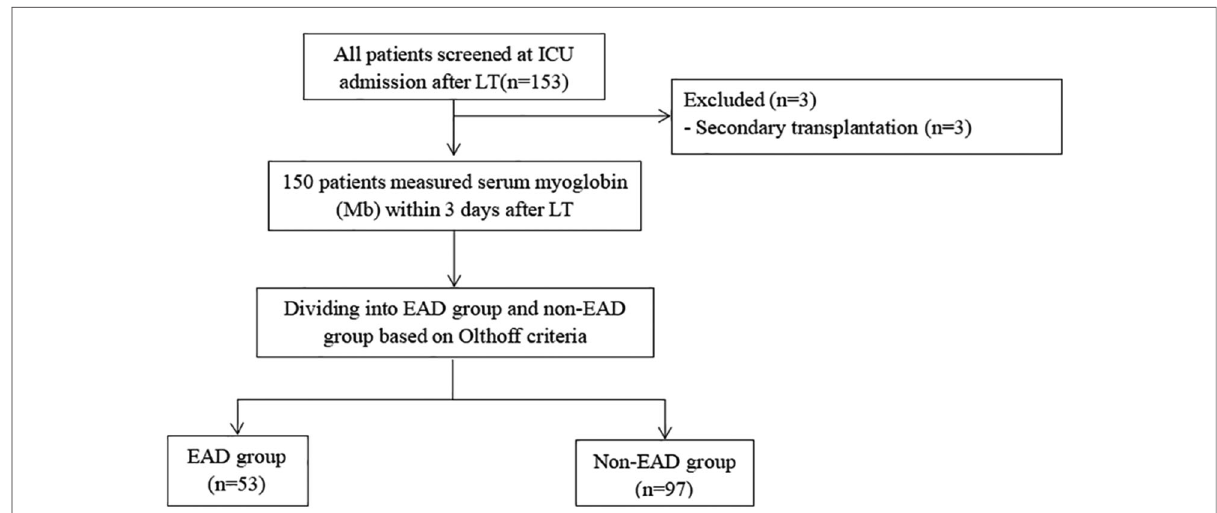
FIGURE 1 Study fl ow chart. Three patients with secondary transplantation were excluded. A total of 150 patients were included for analysis. ICU, intensive care unit; LT, liver transplantation; POD, postoperative day; Mb,